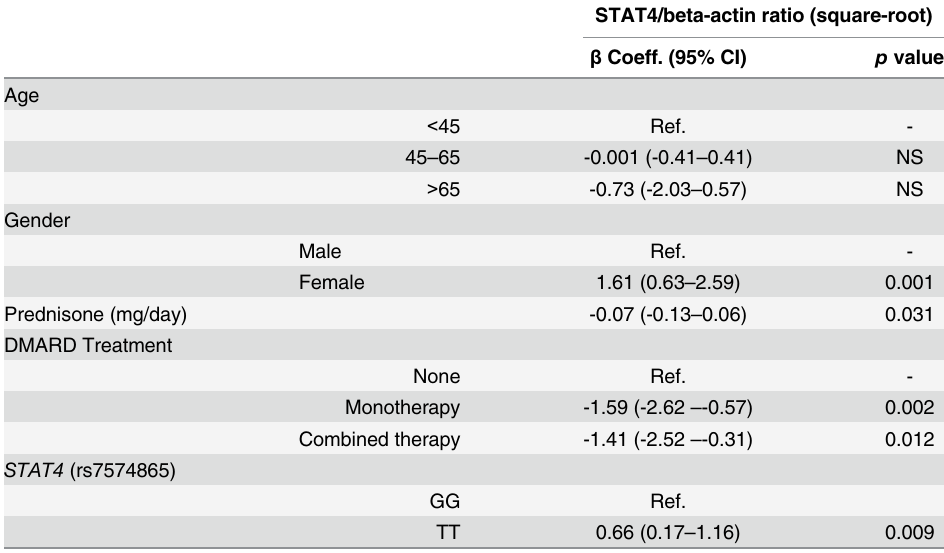
Table 3. Effect of different variables on STAT4 protein expression in patients with early